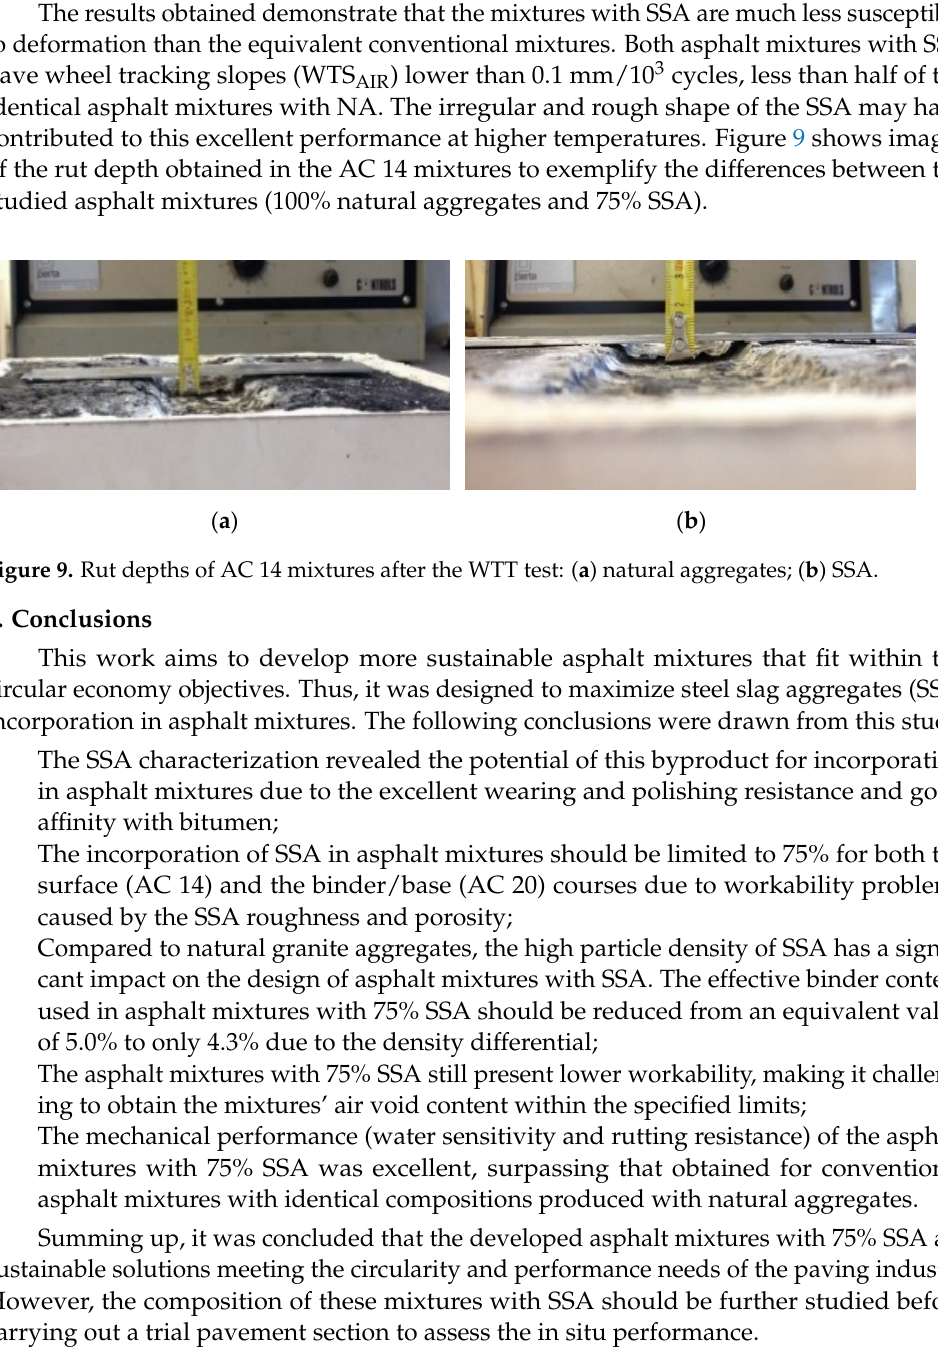
WTS AIR (mm/10 3 Cycles)